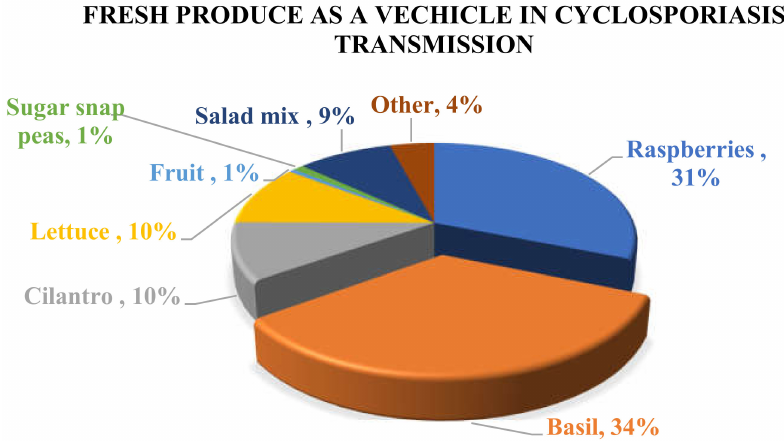
Figure 1. Distribution of C. cayetanensis in di ff erent fresh products that have been reported as the source of cyclosporiasis in humans from